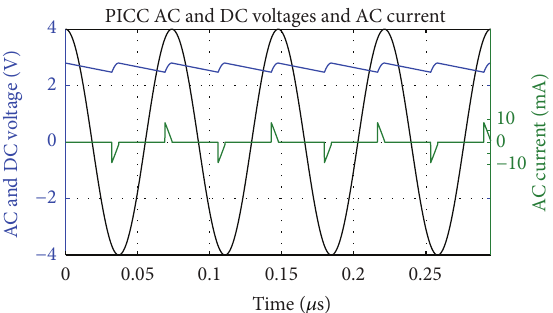
Figure 7: Rectifier AC current and voltage and DC voltage.